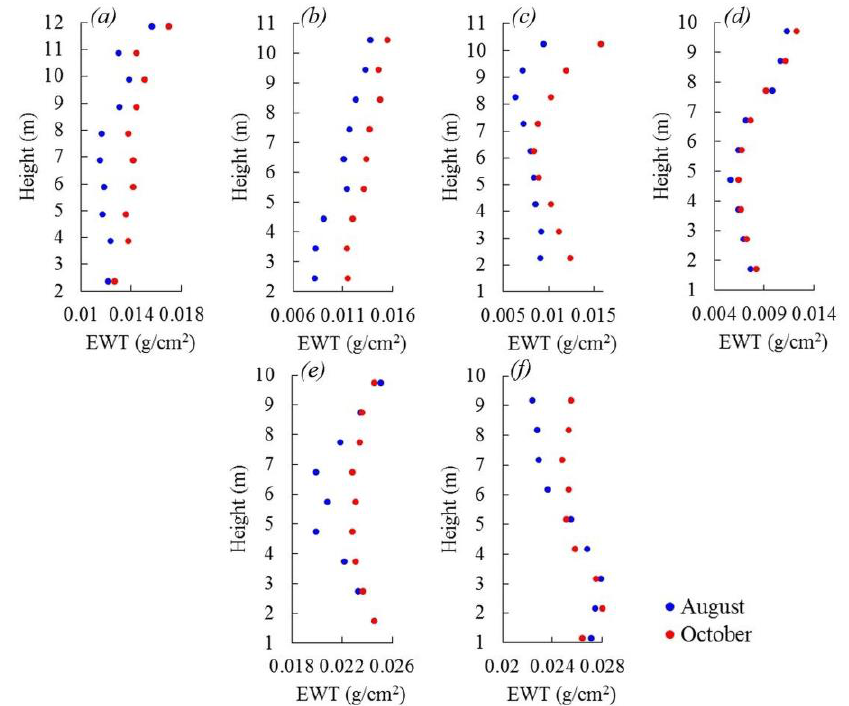
Figure 6. EWT vertical profiles in August (blue) and October (red): ( a ) Ash tree 1; ( b ) Ash tree 2; ( c ) Swedish whitebeam tree 1; ( d ) Swedish Whitebeam tree 2; ( e ) Holly tree 1; and ( f ) Holly tree 2. Both ash trees had higher EWT in canopy top than in the canopy bottom in August and